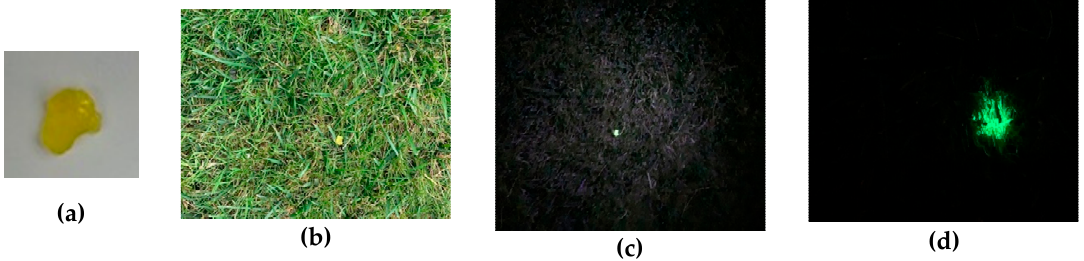
Figure 1. ( a ) Polymer under white light illumination. ( b ) Polymer dispersed in the grass under white light, analog to the cell staining technique. ( c ) Polymer dispersed in the grass under UV light, analog to the luminescence imaging technique. ( d ) Persistent luminescent material dispersed in the grass.